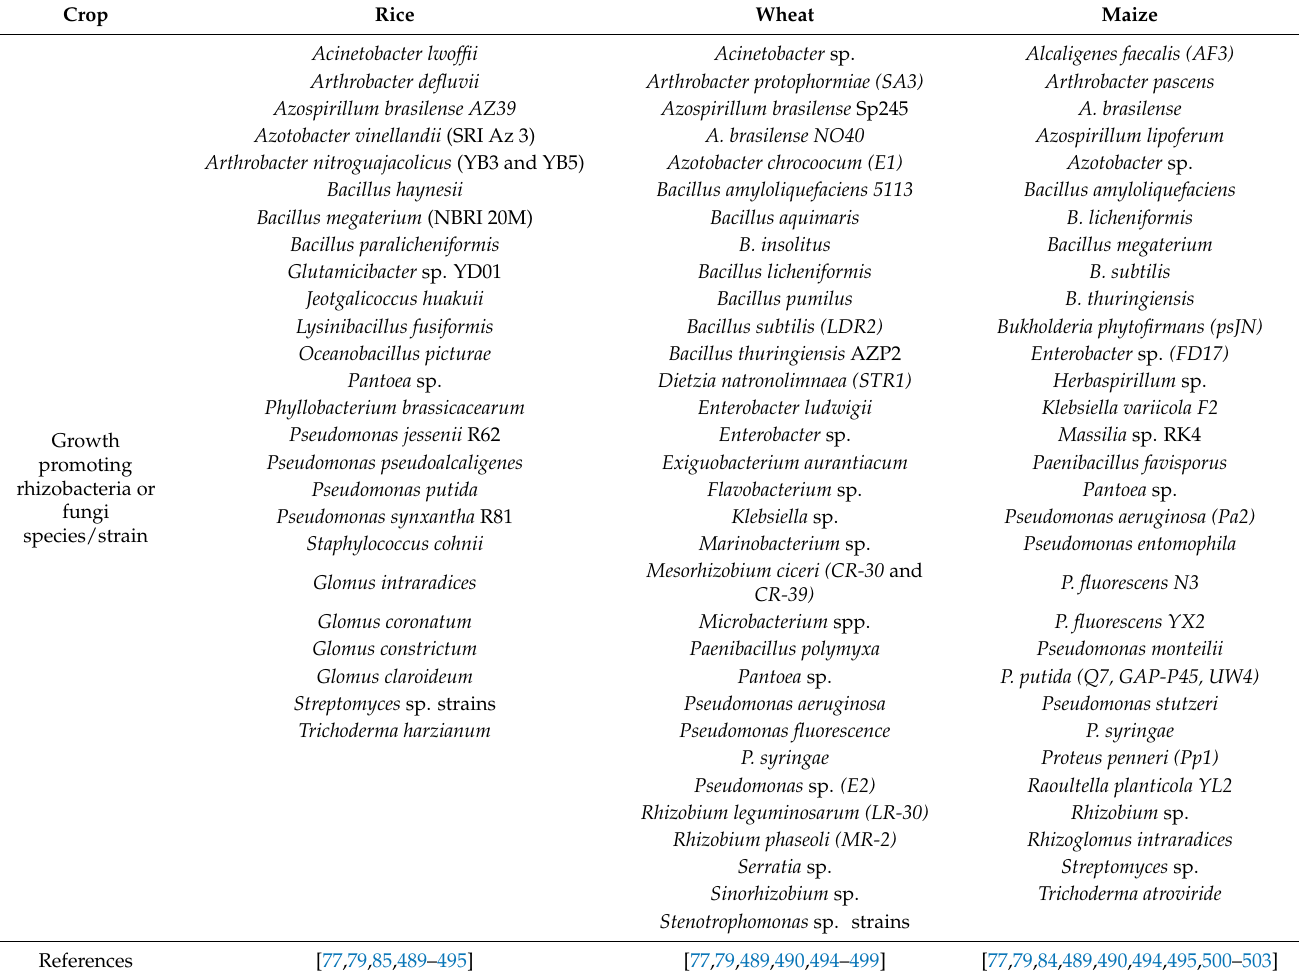
Table 3. Examples of effective microbes used to combat abiotic stress in the three main cereal crops, rice, wheat, and